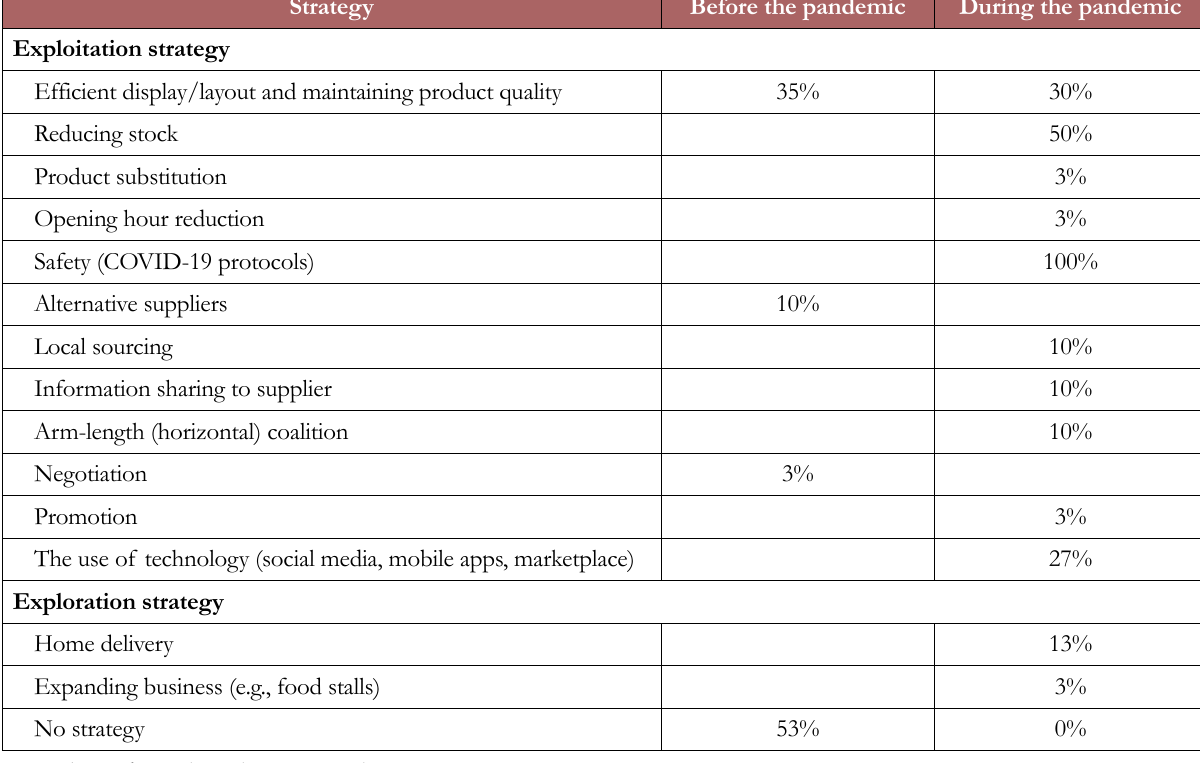
Table 4. Resilience strategies before and during the COVID-19